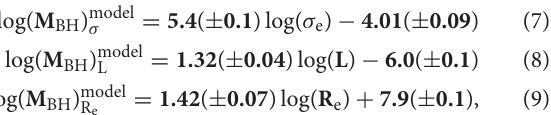
FIGURE 2 | Identical analysis to Figure 1 , but only early type galaxies. Correlations with velocity dispersion are